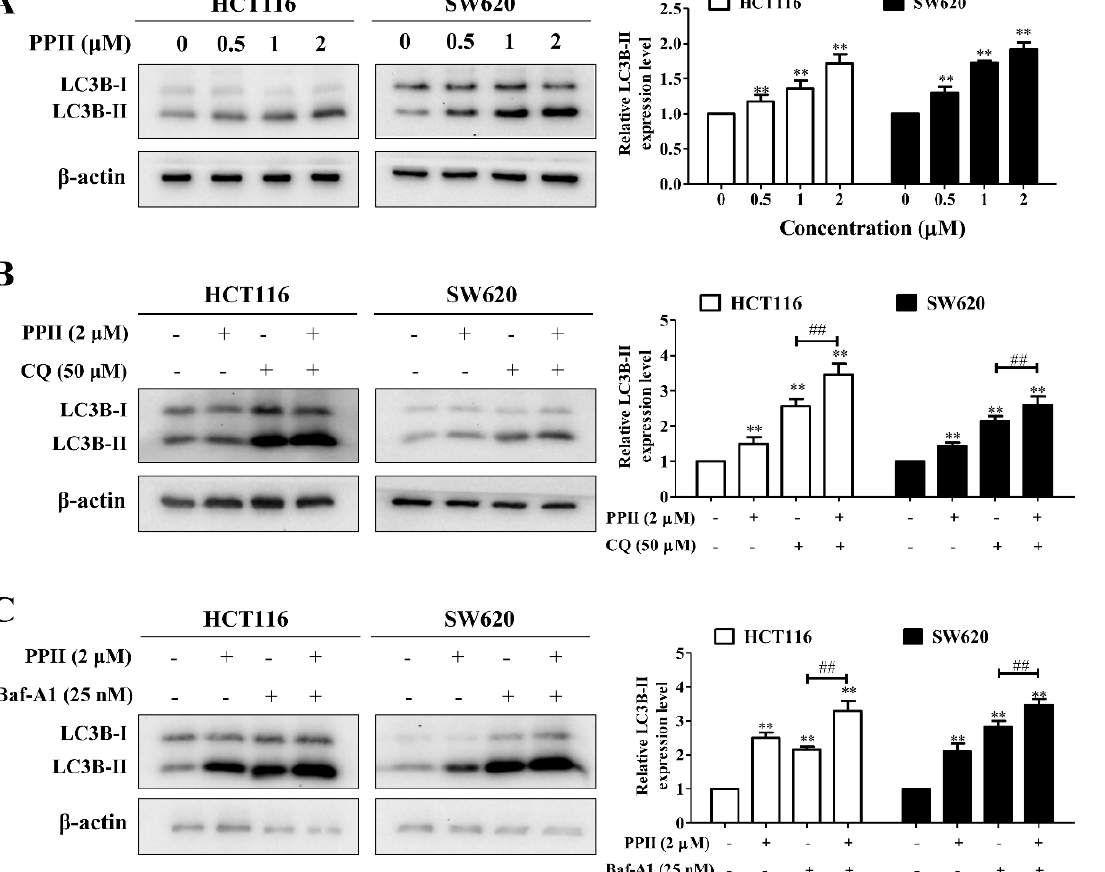
Figure 4. PPII induces autophagy in CRC cells. ( A ) PPII upregulated the protein level of LC3B − II. Representative immunoblotting bands are presented in the left panels, and the quantitative results